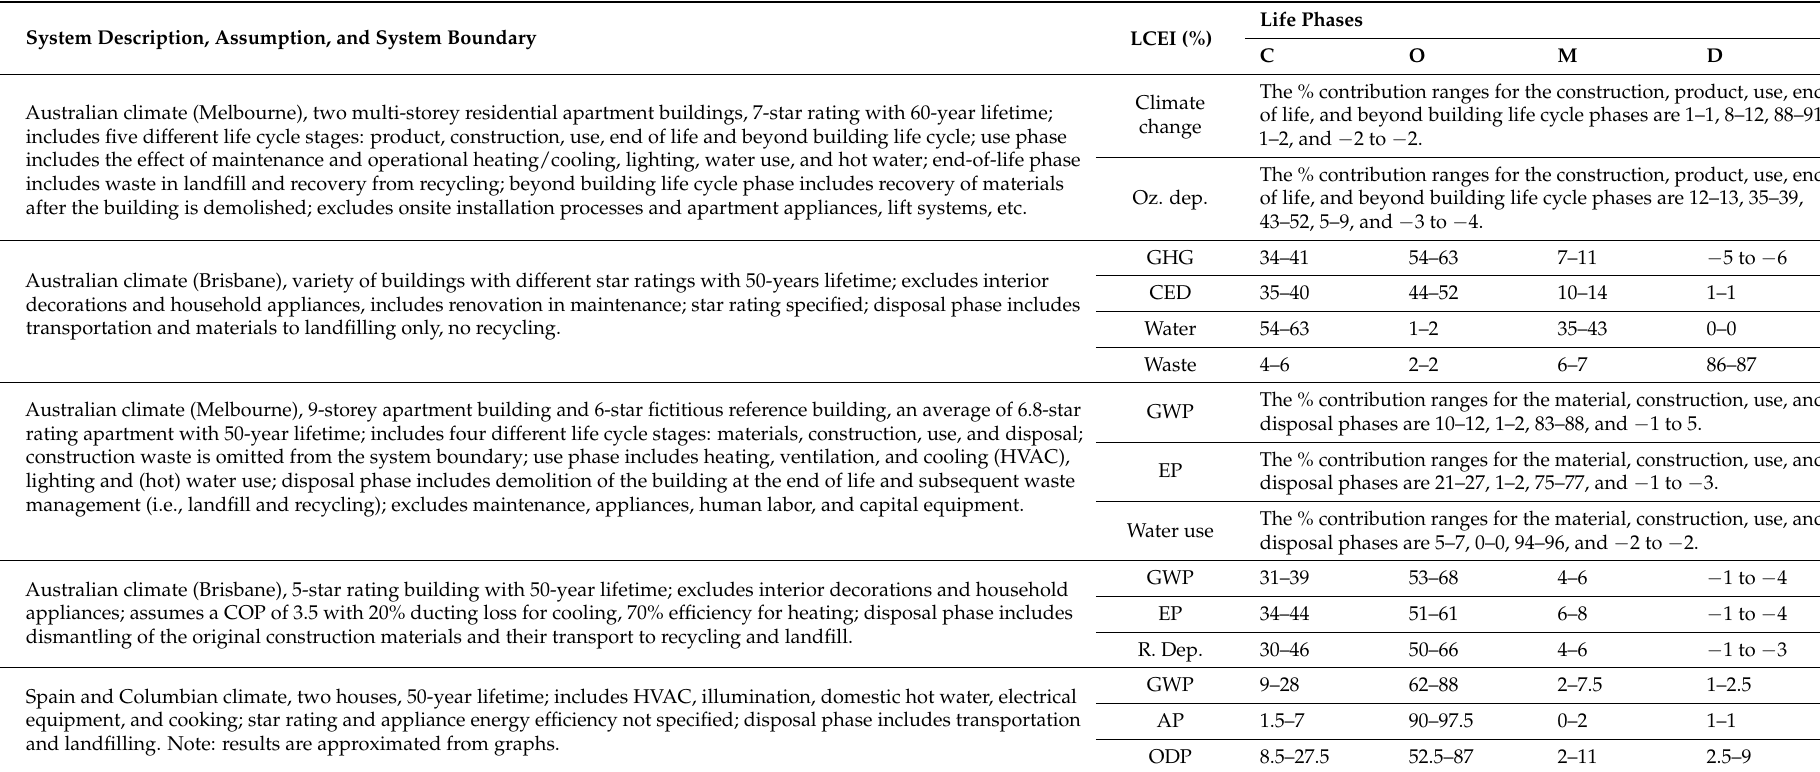
Table 1. Summary of recent life cycle environmental assessment studies of